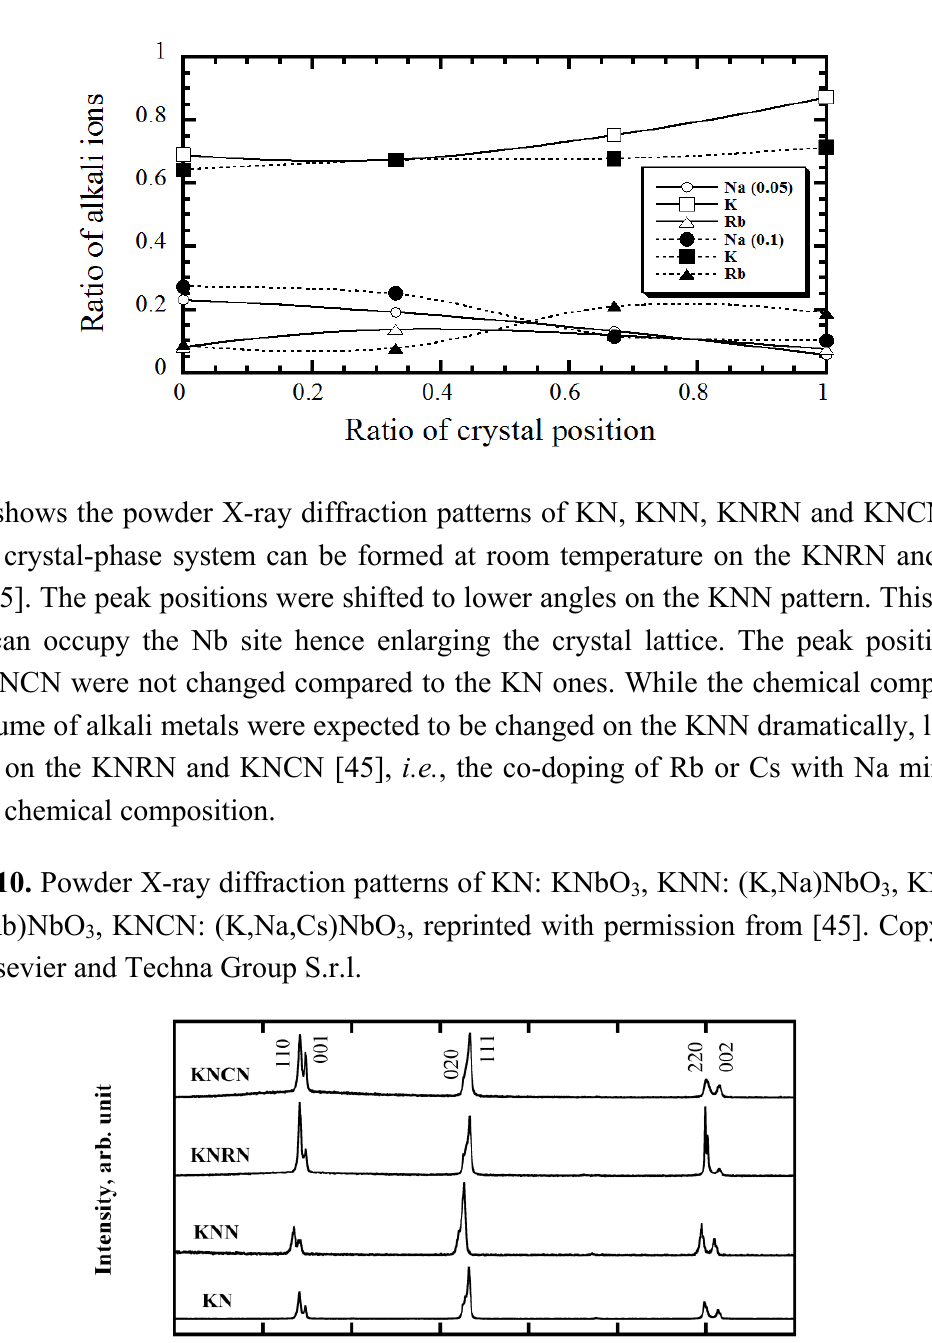
KNRN: (K,Na,Rb)NbO , reprinted with permission from [41]. Copyright 2010 Elsevier. 3 Starting Na content: 5% and 10%.